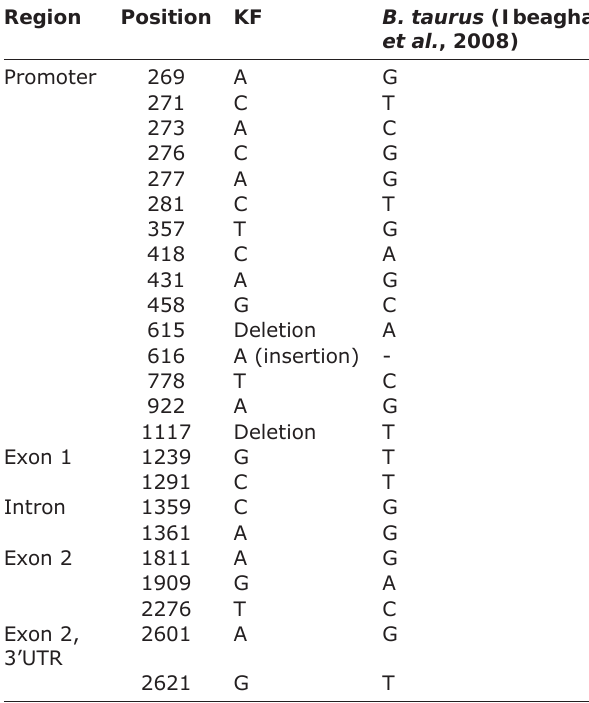
Table-2: Summary of nucleotide changes in CD14 gene of KF as compared to B. taurus (EU148610.1).